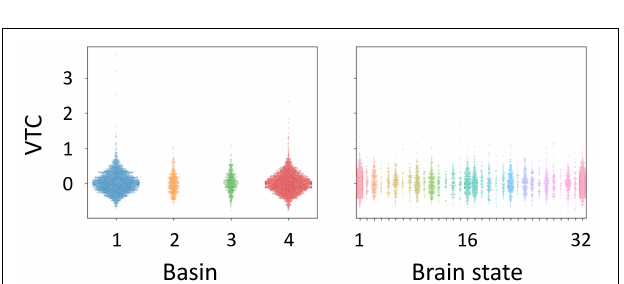
FIGURE 6 | Variance time course (VTC) values identified for each basin and each brain state in the energy landscape. VTC values shown here were subtracted by the median VTC value of each run. Positive values correspond to out-of-the-zone